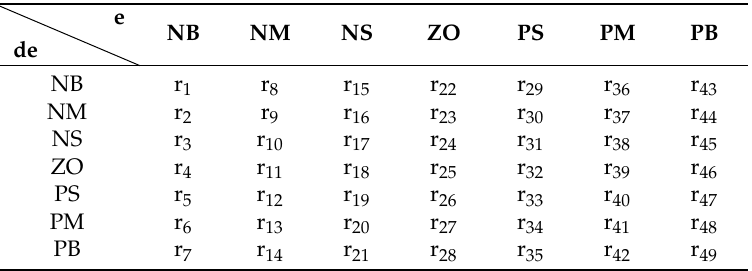
Table 2. Fuzzy inference rules with PSO